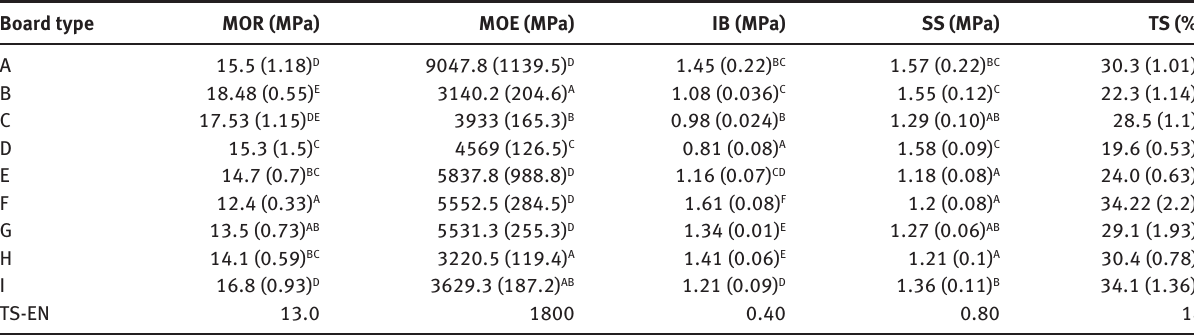
Each value represents the mean of at least five replications (standard deviations in parentheses). Values sharing the same capital letter within a column are not statistically different at the 0.05 level of